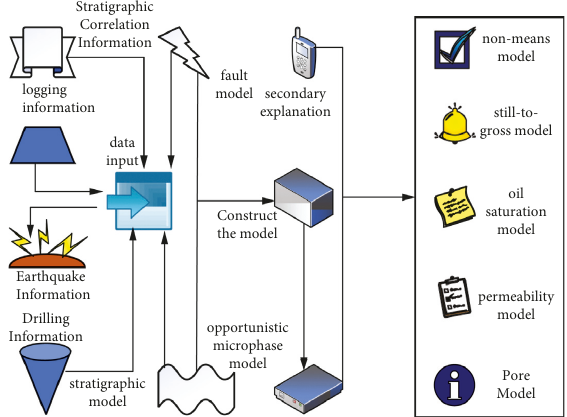
Figure 3: Modeling of 3D tight oil geological